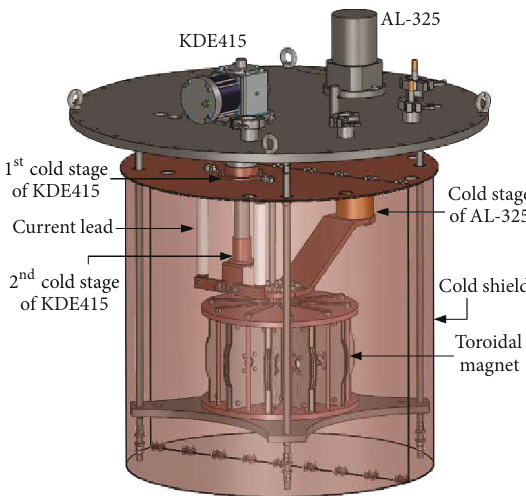
Figure 1: The conduction cooling scheme of the magnet system.